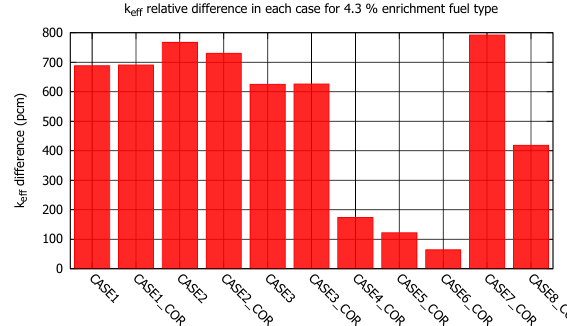
Figure 5. Relative eigenvalue differences in the cal- culation modes with 4.3% enrichment fuel test case